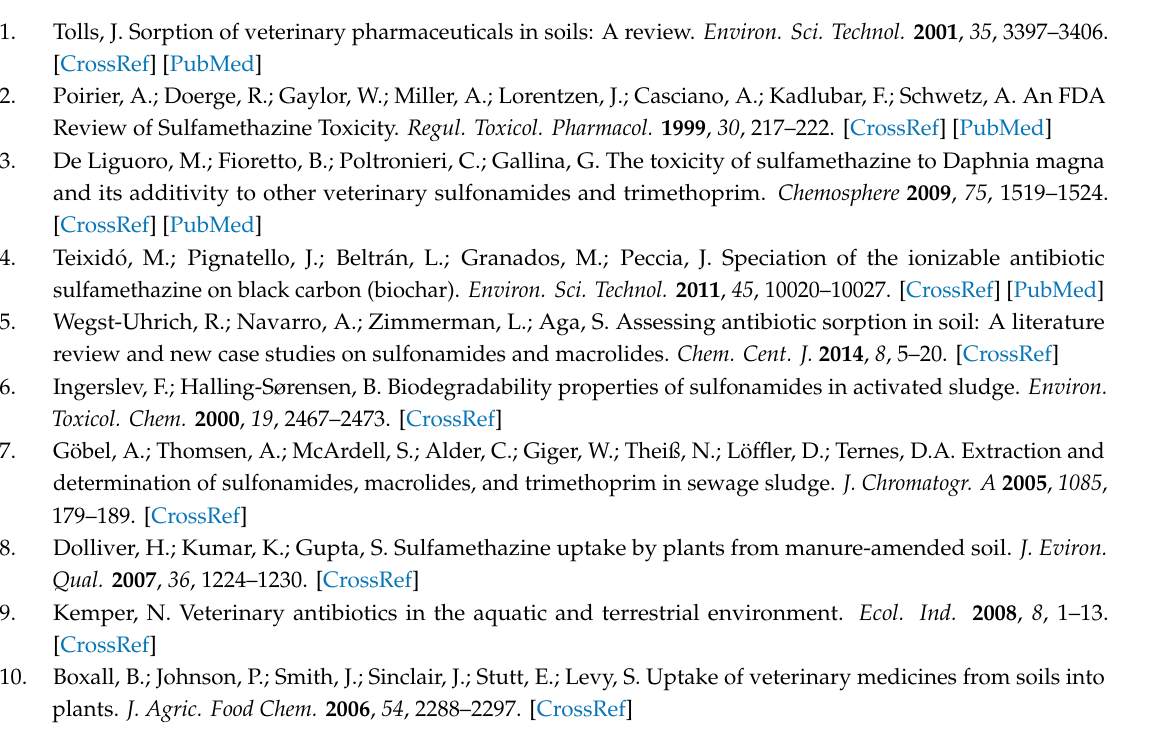
Figure S1: E ff ect of SMT-concentration on the degradation kinetics under (a) simulated solar light and (b) visible light irradiation. Solution parameters: [catalyst] = 500 mg / L, initial pH 7.0, solar light intensity 50.1 mW / cm2 and visible light intensity 38.9 mW / cm2, Figure S2: E ff ect of ZnO / Cux = 1.25O concentration on the SMT-degradation kinetics under (a) simulated solar light and (b) visible light irradiation. Solution parameters: [SMT] = 2.5 mg / L, initial pH 7.0, solar light intensity 50.1 mW / cm2 and visible light intensity 38.9 mW / cm2, Figure S3: HPLC spectra of 2.5 mg / L sulfamethazine in the presence of (a) no NaN3, (b) 0.01 mM NaN3, (c) 0.1 mM NaN3 and (d) 0.5 mM NaN3. Note that the peak areas of (a), (b), (c) and (d) are 122.7, 131.5, 163.0 and 184.1, Figure S4. E ff ect of solution pH on the SMT-degradation kinetics by ZnO / Cux = 1.25O under (a) simulated solar light and (b) visible light irradiation. Solution parameters: [catalyst] = 500 mg / L, [SMT] = 2.5 mg / L, solar light intensity 50.1 mW / cm2 and visible light intensity 38.9 mW / cm2, Table S1: The pH value of SMT solution after photodegradation by ZnO / Cux = 1.25O under simulated solar light for a certain time, Table S2. The pH value of SMT solution after photodegradation by ZnO / Cux = 1.25O under visible light for a certain